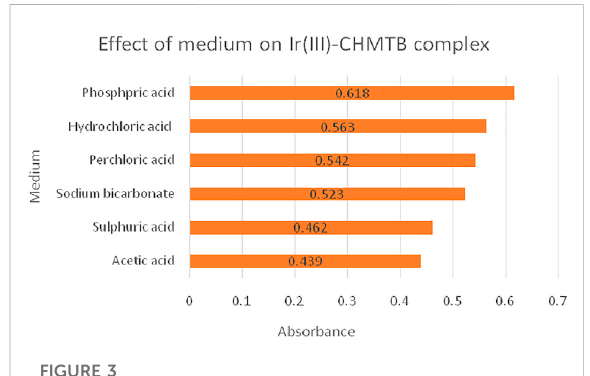
FIGURE 3 Absorbance of Ir (III)-CHMTB complex in different media.